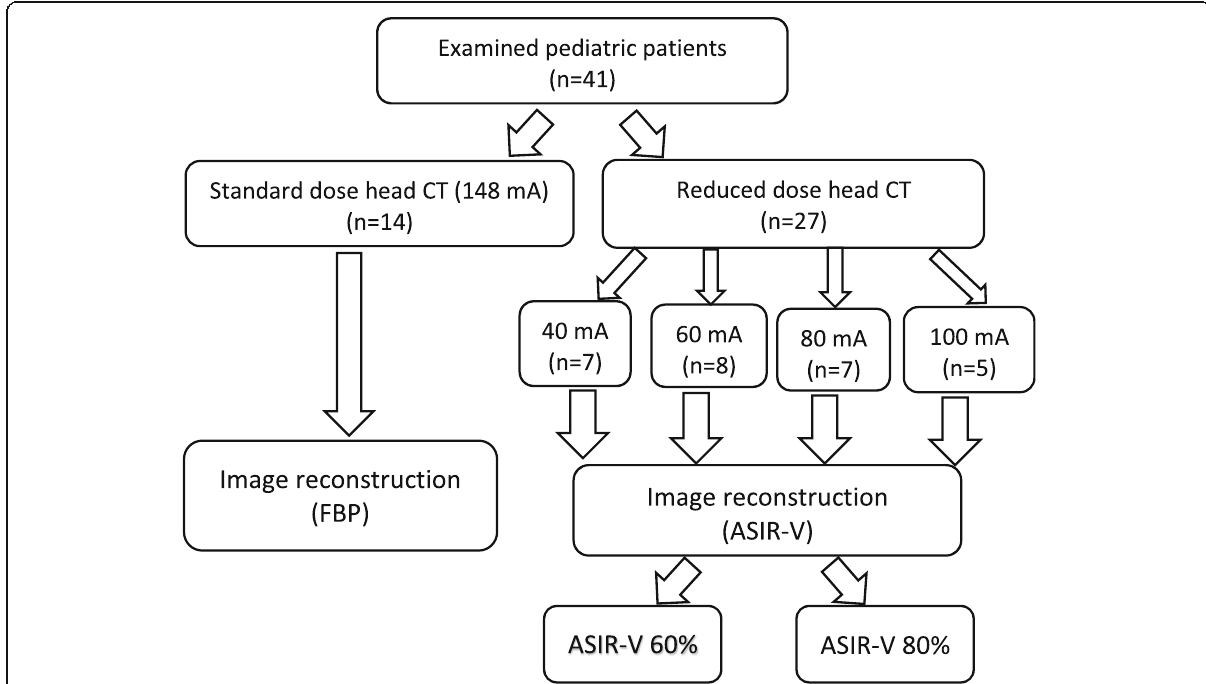
Fig. 1 Flowchart of head CT acquisition and reconstruction of ASIR and non-ASIR